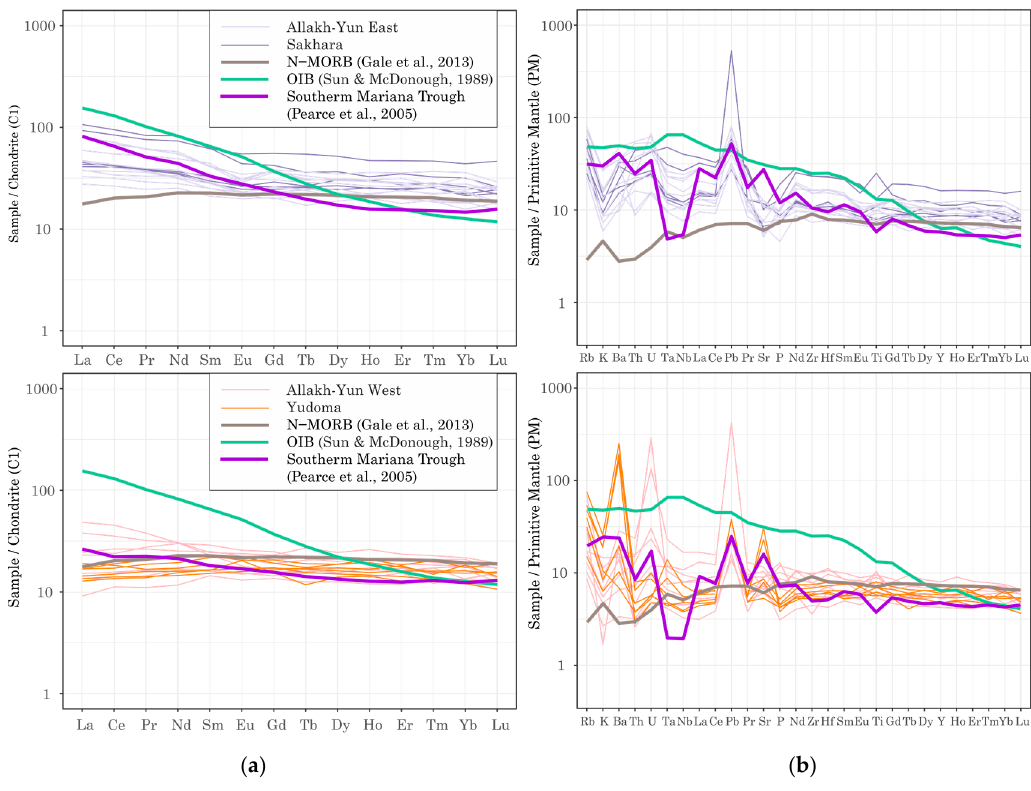
Figure 6. ( a ) Chondrite-normalized rare earth elements (REE) plot and ( b ) primitive mantle-normalized trace element diagram for the Sette-Daban magmatic event intrusions. The trace element compositions of ocean island basalts (OIB), along with chondrite and primitive mantle normalization values, are from [26]. The trace element compositions of normal mid-ocean ridge basalt (N-MORB) are from [27]. Trace element compositions of the southern Mariana Trough are from [24].